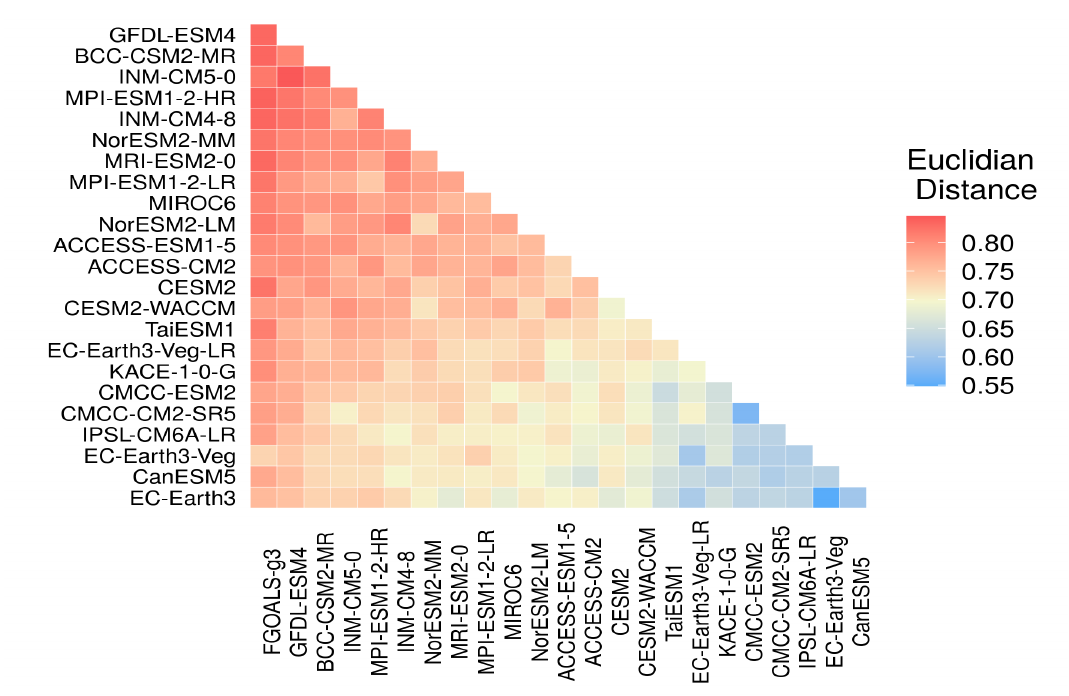
Figure 2. A heatmap of the intermodel distance matrix, computed from the five climate variables for the Middle East, using the historical data and the future simulation data, for the 24 Coupled Model Inter-Comparison Project Phase (CMIP) 6 models. Each box shows a pairwise combination, where red color show a greater independence and blue color show a greater dependence.